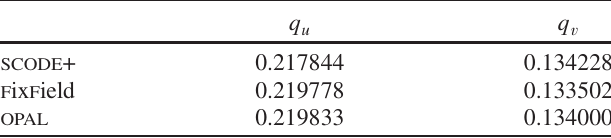
TABLE VI. Comparison of results from three different codes.